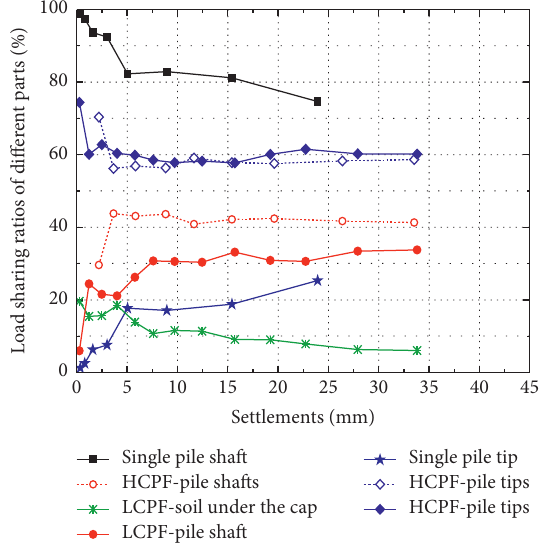
Figure 7: Variation curves of the load of different parts of the pile foundation with its total load.